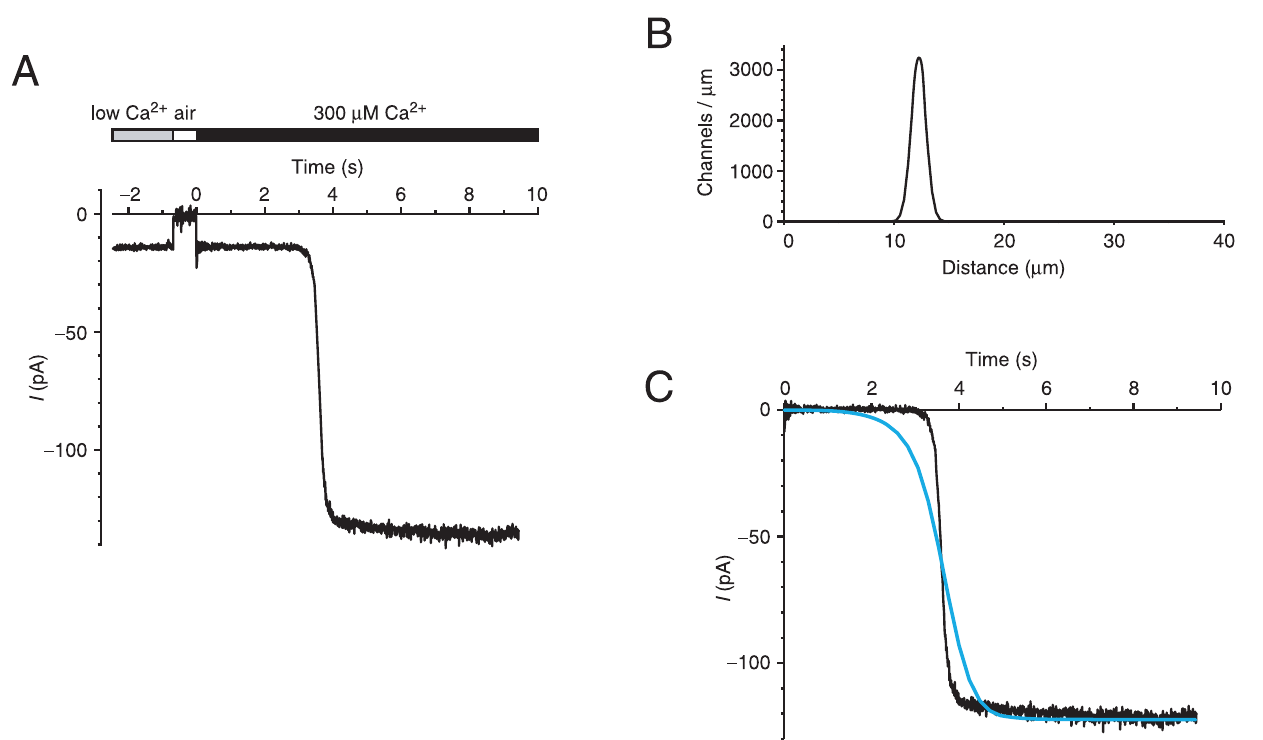
Figure 2. Time course of the Cl 2 current activated by diffusion of Ca 2 + into a cilium. (A) At the start of the recording, the 40- m m-long cilium was in a pseudointracellular bath containing , 0.1 m M free Ca 2 + and showed a leak current of 2 14 pA. The cilium was briefly moved through the air, during which time the current was 0 pA. At the time labeled 0, the cilium was immersed in a bath containing 300 m M free Ca 2 + . After a delay, this activated a current with a steep slope. The onset (time to reach 10% of the activated current) was 3.4 s. Both baths contained 2 mM BAPTA. Pipette potential was clamped at 2 50 mV throughout the experiment. (B) The channel density function predicted by the inverse solution applied to the recording shown in (A). The density function consists of a band of 5400 channels centered at a distance 12.2 m m from the base of the cilium. (C) A forward calculation from the density function shown in (B) predicted the current shown as a blue line. The original recording (A), with the leak current subtracted, is shown again in (C) for comparison.